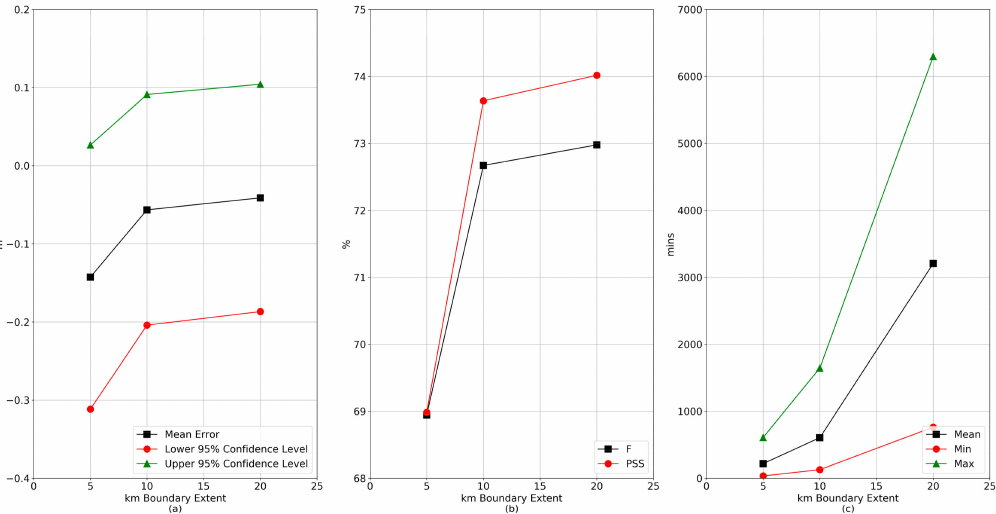
Figure 9. The changes in the statistics of the simulated peak water surface elevations ( a ) and maximum extents ( b ) as well as the changes in the computational costs ( c ) along with the increase in the size of the forcing domain. The forecast streamflow of 8 October 2016 was used for all simulations. Abbreviations: F , the measure of fit; PSS , Peirce’s skill score.